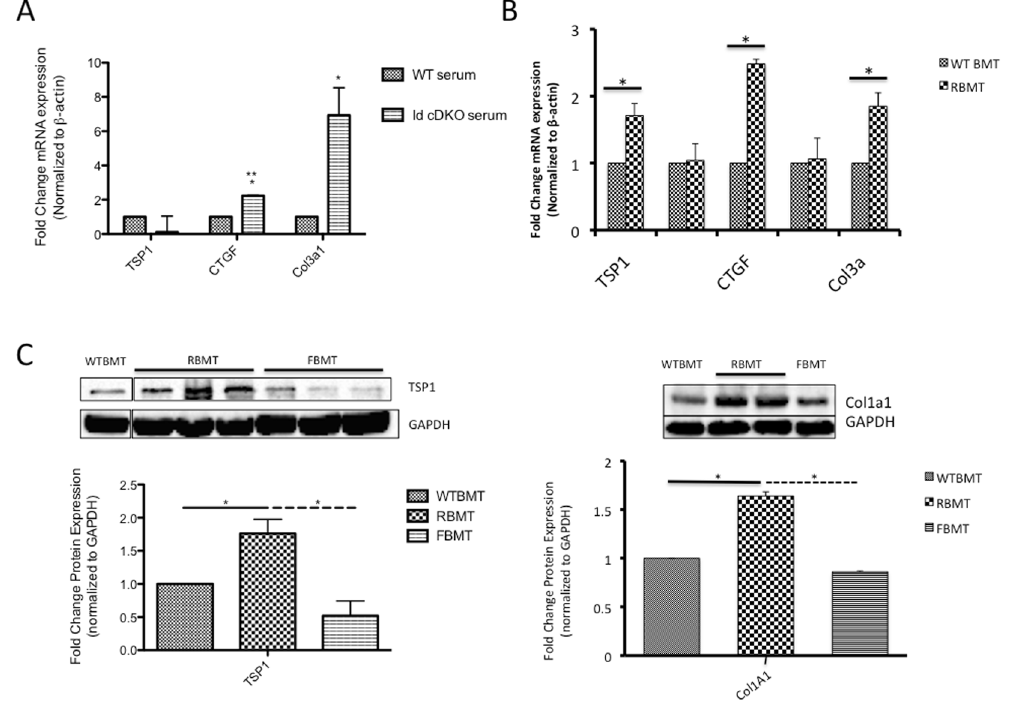
Figure 5. Activation of TSP1/CTGF/Collagen in RBMT hearts. ( A ) Incubation of 1 mm WT cardiac sections (obtained from 2 month-old mice) in medium with 2% mouse serum from 2 month old WT and Id cDKO mice. Data expressed as fold change in mRNA expression levels of TSP1, CTGF and Col3a1 in WT cardiac explants treated with Id cDKO serum relative to WT serum treated controls. WT serum treatment (n = 3), Id cDKO serum treatment (n = 3). mRNA expression normalized to β -actin. * p < 0.05, ** p < 0.01. ( B ) Fold change in mRNA expression for TSP1, TGF β 1, CTGF, Col1a1 and Col3a1 in 6 month old WTBMT (n = 4) and RBMT (n = 7) mice. * p < 0.05. ( C ) Representative western blots for TSP1 in WTBMT, RBMT and FBMT hearts at 6 months of age. Lane of WTBMT was not adjacent to lanes of RBMT and blot was cropped. Image of uncropped blot is available as Supplementary Figure 1. Graph on bottom displays quantitation of TSP1 band intensity normalized to GAPDH. * p <